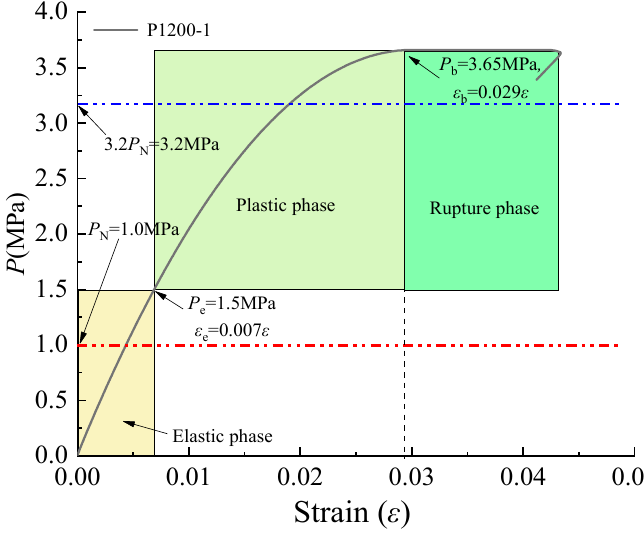
Figure 17. The process of the pipe under pressure (P1200-1).